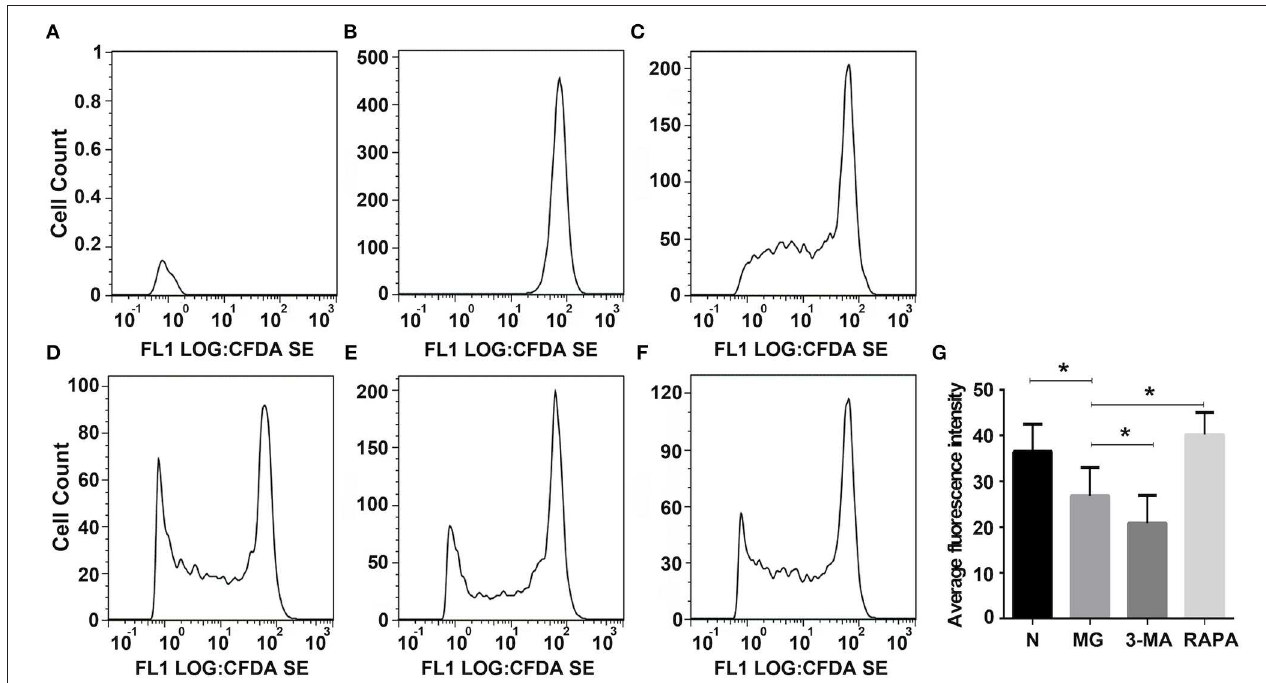
FIGURE 5 | Inhibition of Tregson the proliferation of normal CD4 + T cells. FLOWJO software was used to analyze the flow cytometry pictures. (A) Autofluorescence, (B) not give any irritation, (C) control group added Treg cells were co-cultured, (D) 3-MA pretreated Treg cells were co-cultured, (E) Rapa pretreated Treg cells were co-culture, (F) MG group Treg cells were co-cultured, and (G) Statistical analysis of each group (* P <